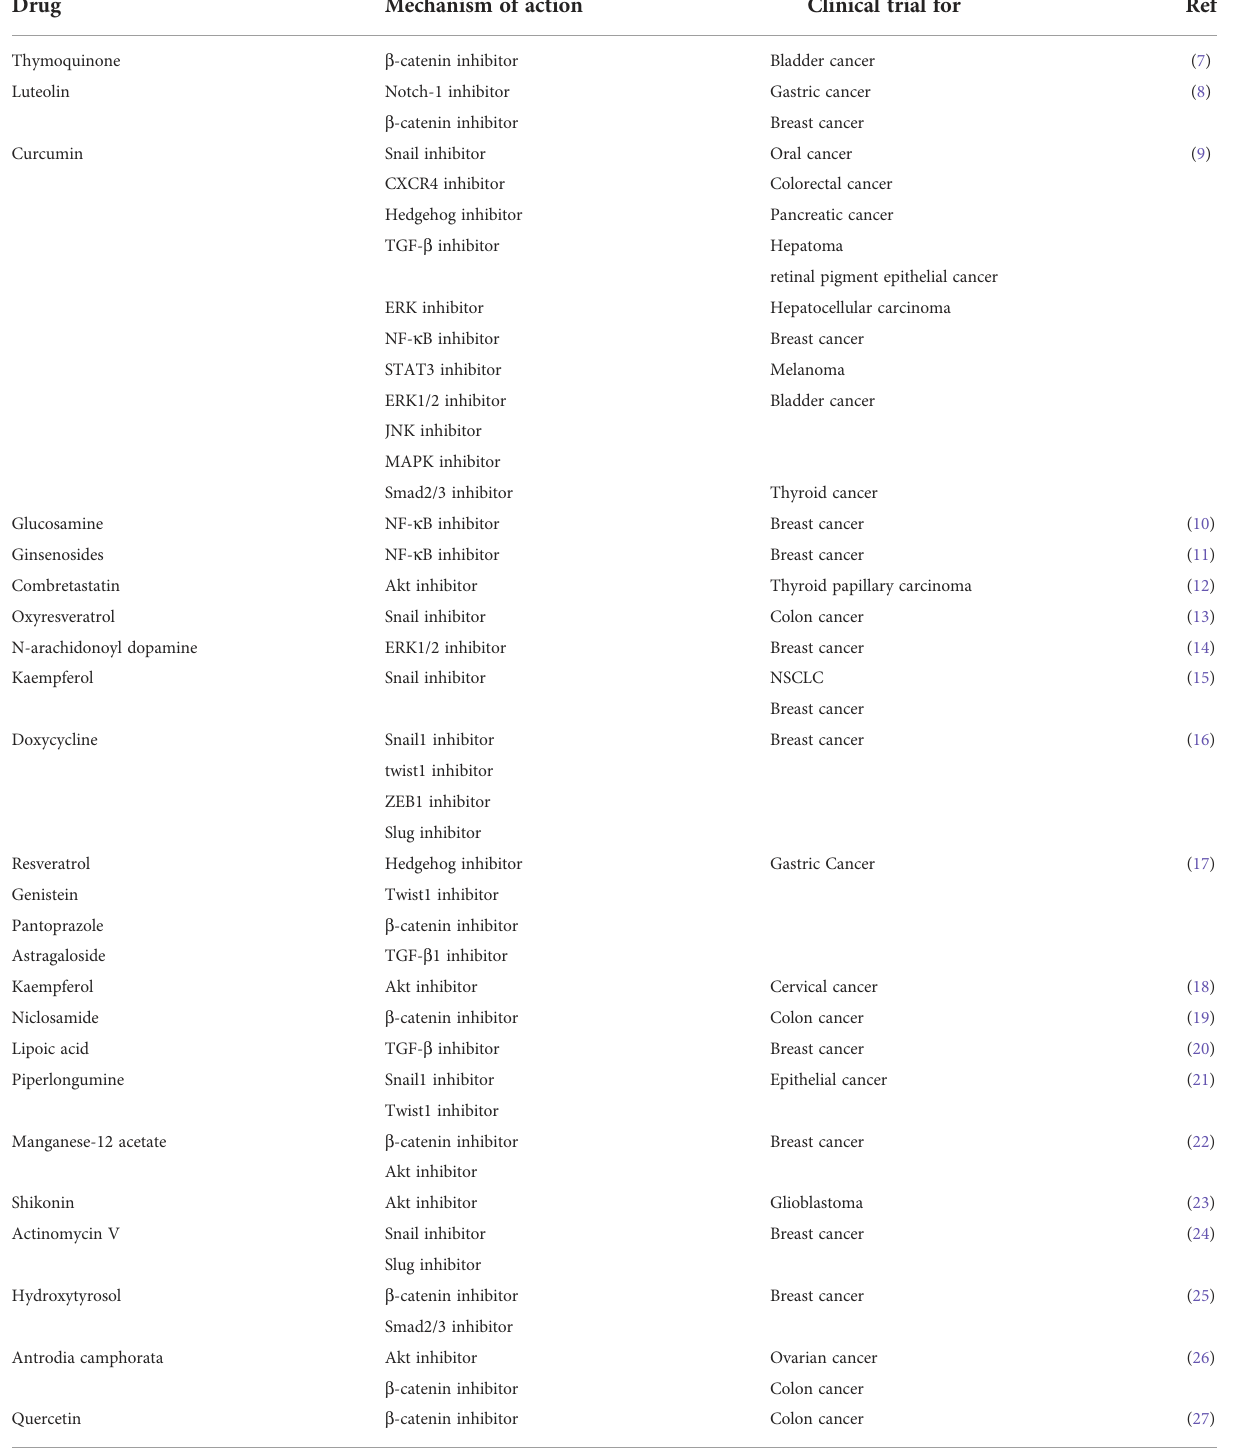
TABLE 1 Classes of synthetic drugs targeting epithelial-mesenchymal